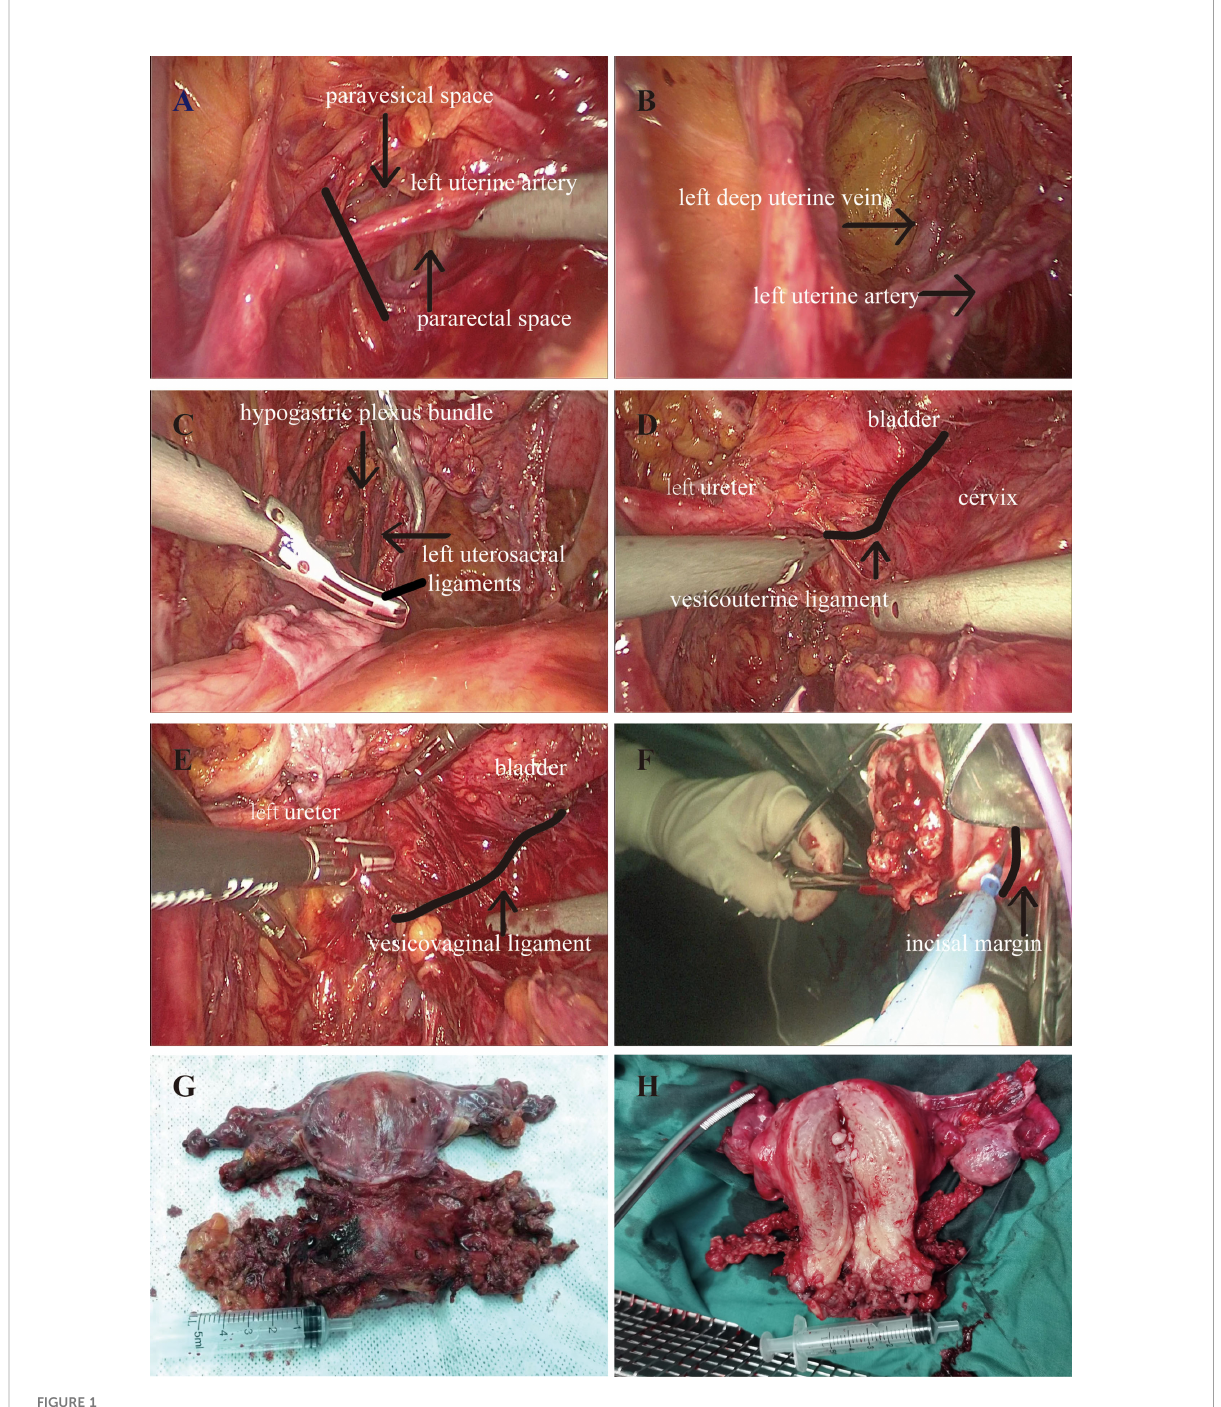
FIGURE 1 Perioperative picture. (A) Resection of the uterine artery. (B) Isolation of the deep uterine vein. (C) Resection of the uterosacral ligaments. (D) Resection of the vesicouterine ligament. (E) Resection of the vesicovaginal ligament. (F) The removal of the uterus. (G, H) Ultra-radical hysterectomy